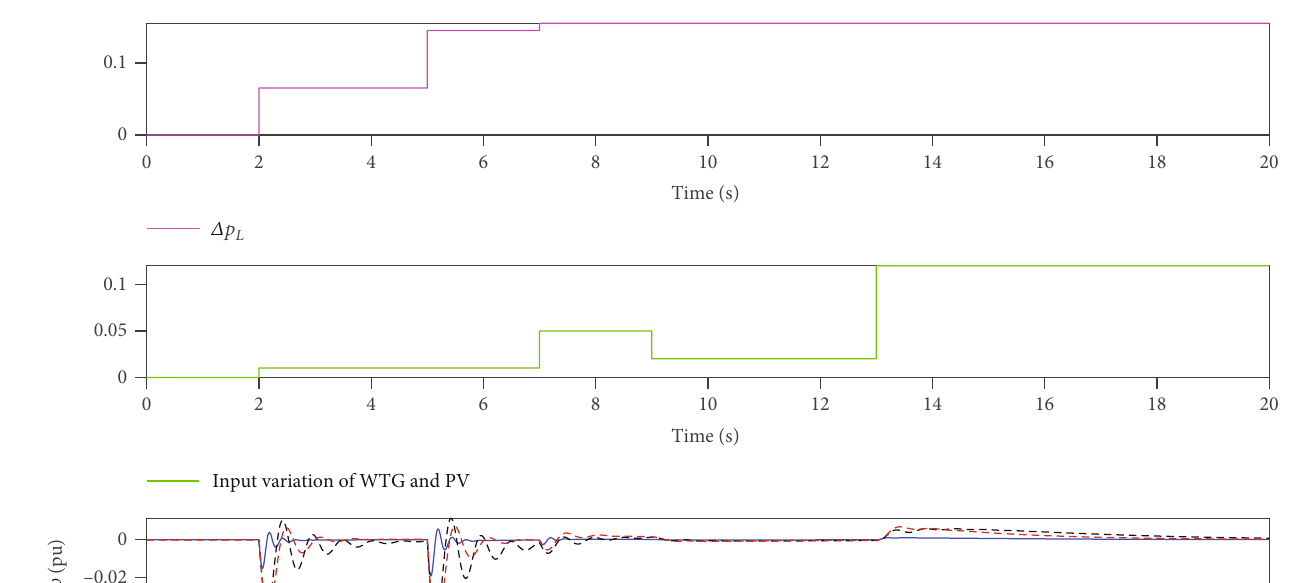
Figure 9: Scenario 2: control